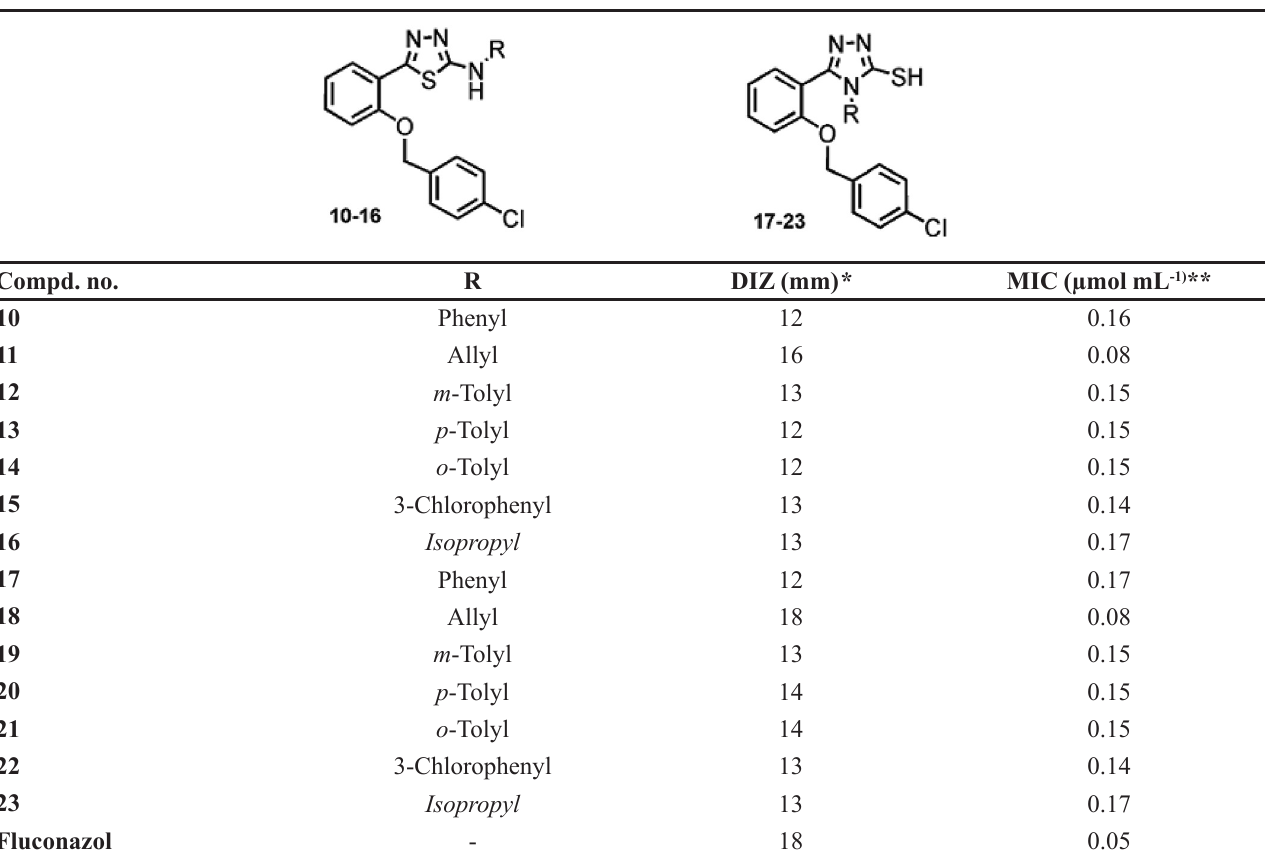
* The arithmetic mean of the inhibition zone diameters in mean ± standard deviation. **The lowest concentration of the compound that produced 50-80% microbial growth inhibition (μmol mL -1 ). Count=14, Mean=0.3, Standard Devation= 0.029, Standard Error=0.008, Sample